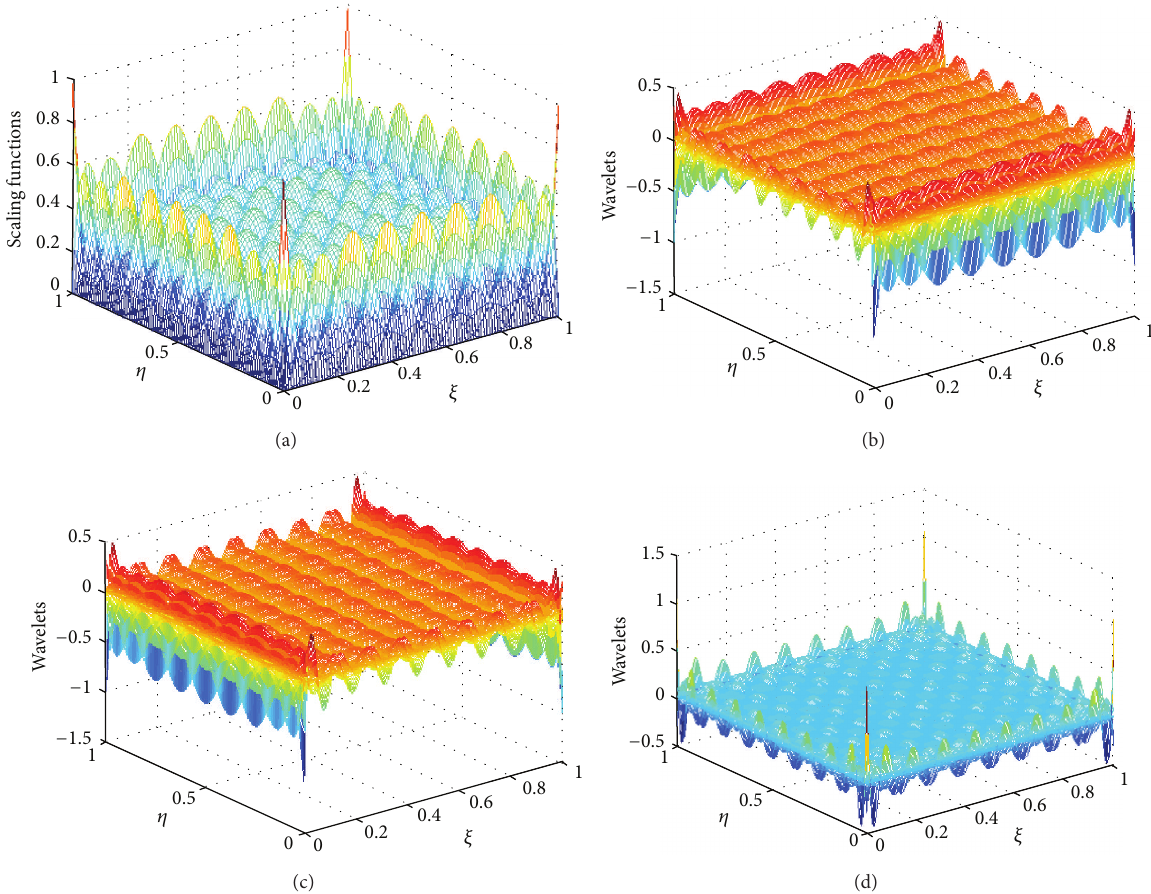
Figure 2: Two-dimensional tensor product BSWI: (a) scaling functions Φ = Φ 1 ⊗ Φ 2 , (b) wavelets Ψ 1 = Φ 1 ⊗ 𝜓 2 , (c) wavelets Ψ 2 = 𝜓 1 ⊗ Φ 2 , and (d) wavelets Ψ 3 = 𝜓 1 ⊗ 𝜓 2